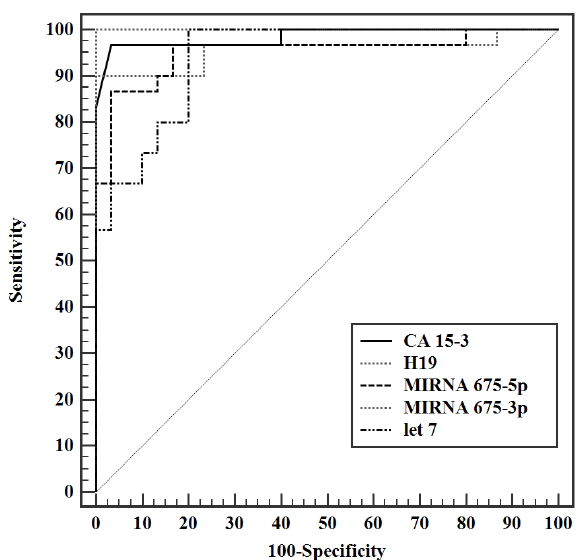
Figure 15. ROC curve for CA 15-3 (U/mL), H19, MIRNA 675-5p, MIRNA 675-3p and let 7 to discriminate pre surgery patients (n = 30) from control (n = 30).